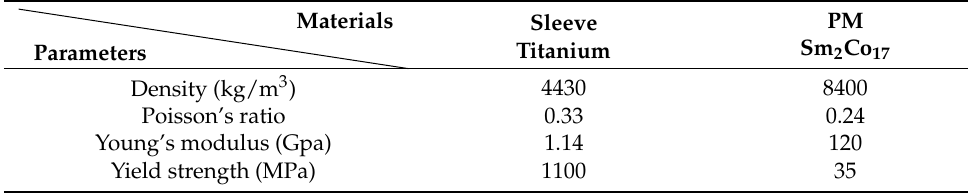
Table 5. Mechanical properties of permanent magnet and sleeve materials.